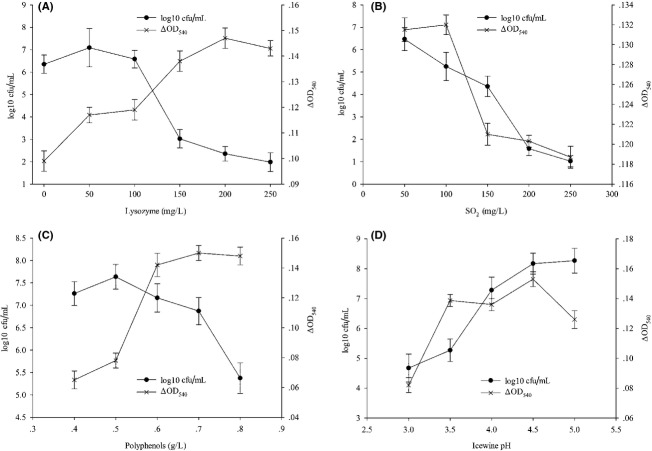
Influence of different concentration of lysozyme (A), SO2 (B), polyphenols (C), and wine pH (D) on LAB inhibition and protein stability. LAB inhibition index log10 CFU mL−1 (full circle) and protein stability index ΔOD540 (cross) were measured at pH 4.27 in the ice wine contaminated with L. plantarum VT12 and O. oeni VP41 (1:1 inoculation ratio). Bars showed standard deviations.